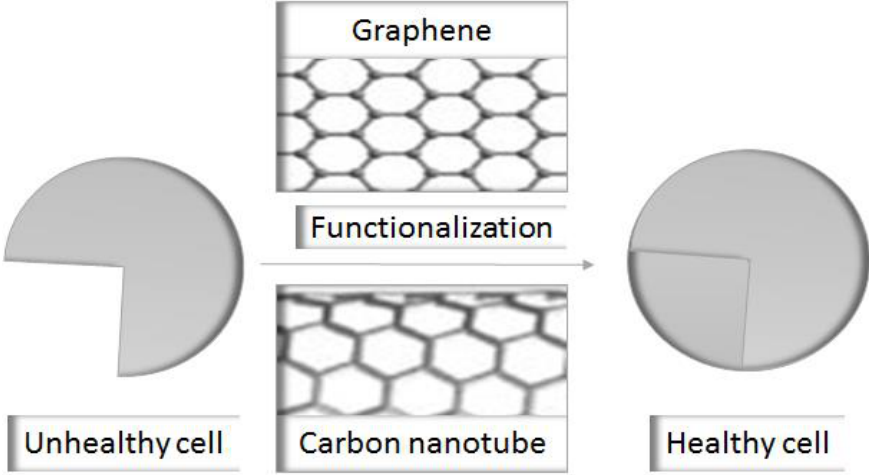
Figure 1. A schematic representation showing the ameliorated effect of functionalization on the cytocompatibility of graphene and carbon nanotubes.